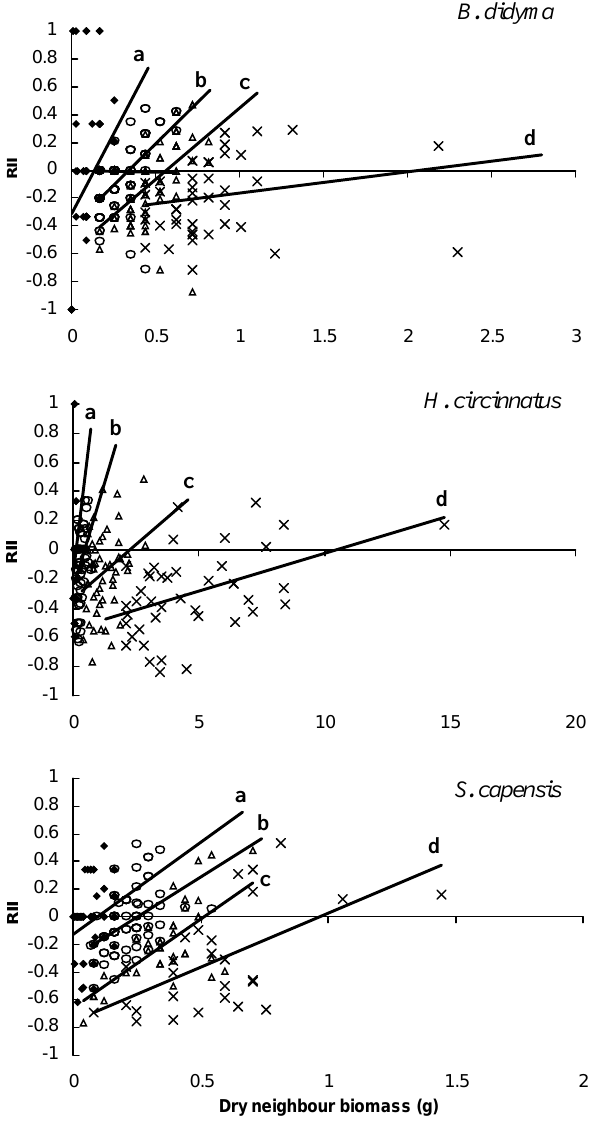
Figure 1. Relationship between interaction intensity (measured as RII) and neighbour biomass for pooled populations of Biscutella didyma , Stipa capensis and Hymenocarpos circinnatus . For all species, separate linear regression lines are presented for data col- lected between 0–3 weeks of age (filled diamonds, line a), 4–6 weeks (open circles, line b), 7–9 weeks (open triangles, line c) and 10–13 weeks (x marks, line d), except for B. didyma where (d) was calculated for the 10–12 weeks age